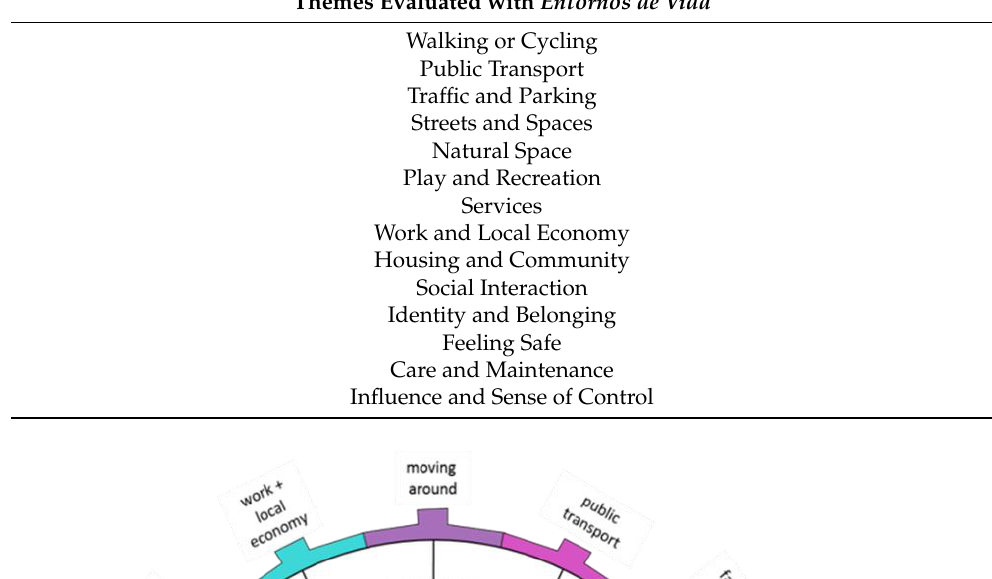
Table 1. The 14 topics of the physical, social, and economic environment assessed using the EdV tool.